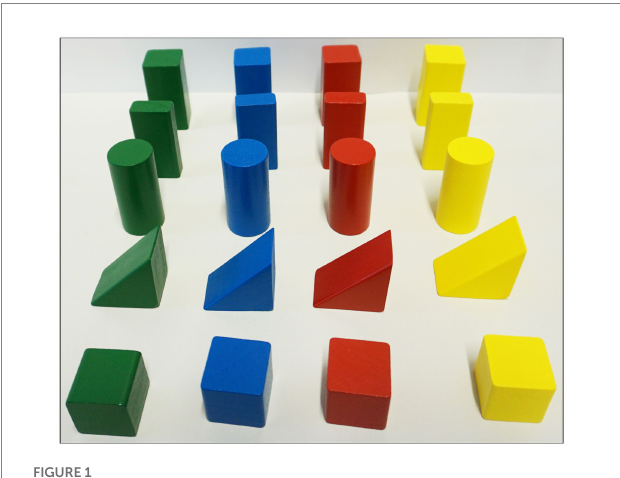
FIGURE 1 Stimulus material: Building blocks in 5 different shapes and 4 different